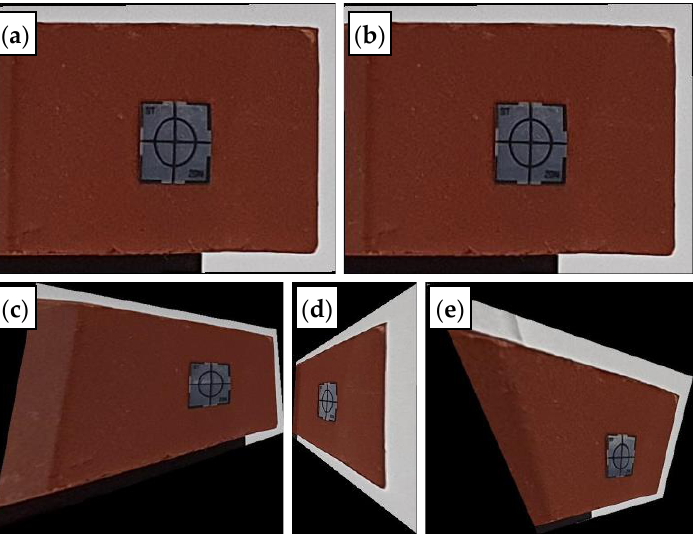
Figure 7. Successful and failed transformed image results. ( a ) Successful result with KAZE (incidence angle = 60°, combined displacement); ( b ) successful result with SURF (incidence angle = 60°, combined displacement); ( c ) failed result with MinEigen (incidence angle = 70°, facing displacement); ( d ) failed result with ORB (incidence angle = 30°, facing displacement); ( e ) failed result with BRISK (incidence angle = 40°, combined displacement).